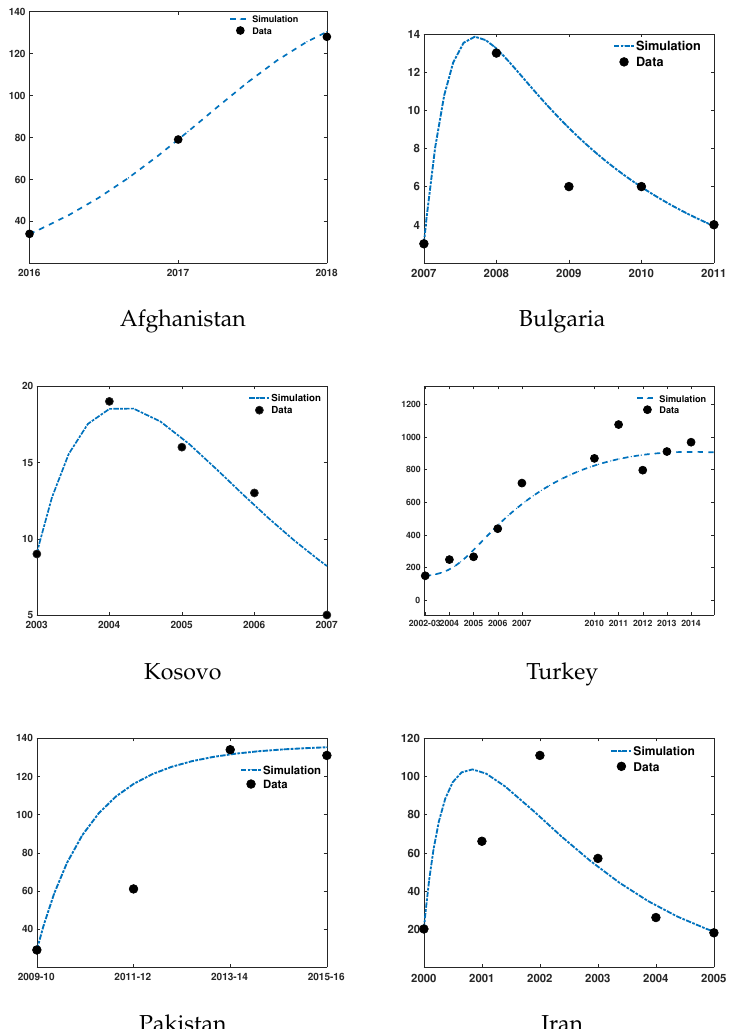
Figure 5. Reported human CCHFV cases in Afghanistan, Bulgaria, Kosovo, Turkey, Pakistan and Iran and the simulation of H I ( t ) from the model fitted to these data points. The outbreak data are all collected from [11,15,65–68].